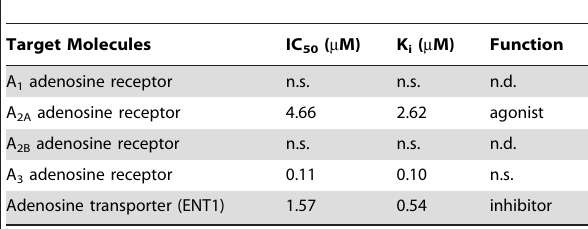
Table 1. Pharmacological properties of T1-11.